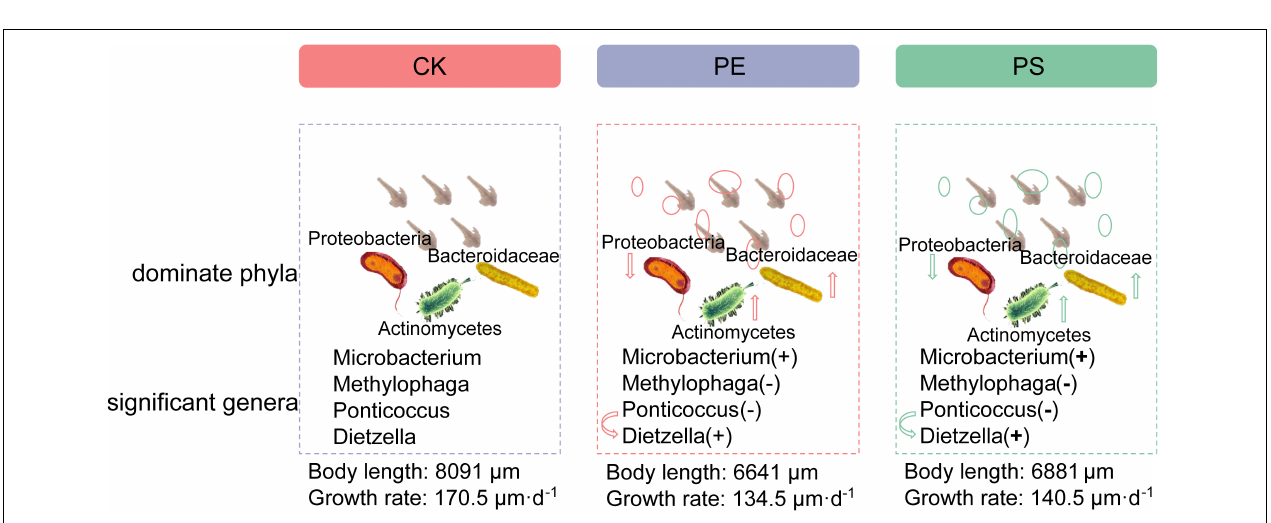
FIGURE 10 | The phylogenetic tree of intestinal species at the genus level. It is based on the top 20 species in relative abundance. The left panel shows the phylogenetic tree, and the right panel denotes the species proportion relationship.